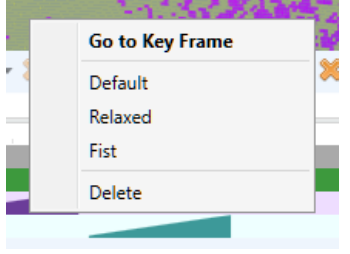
Figure 7. Hand gestures in iPi MoCap Studio The programm also allows users to manually edit movements that are not translated smoothly. It offers the ability to move or